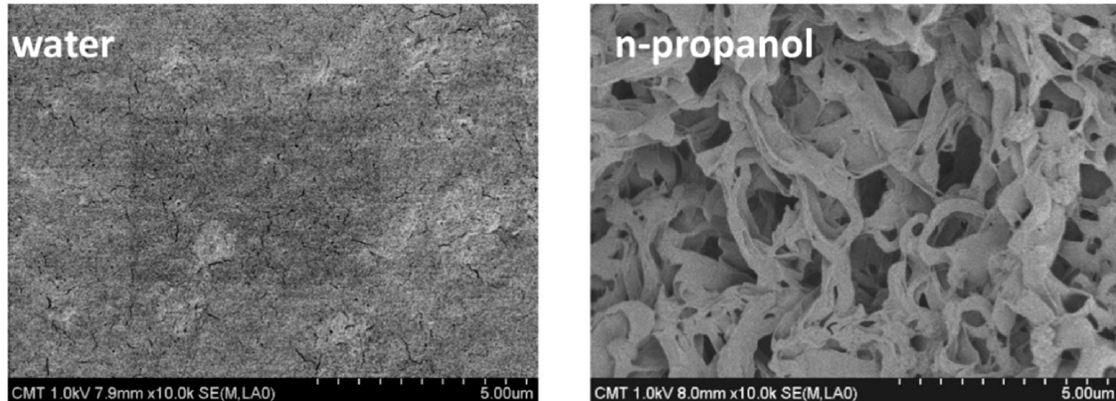
Figure 8. SEM photographs of PVDF membranes prepared by immersing in a water bath and n-propanol bath for 2 s and then immersing into a water bath. Reprinted from [46]. Copyright (2008) with permission from Elsevier.